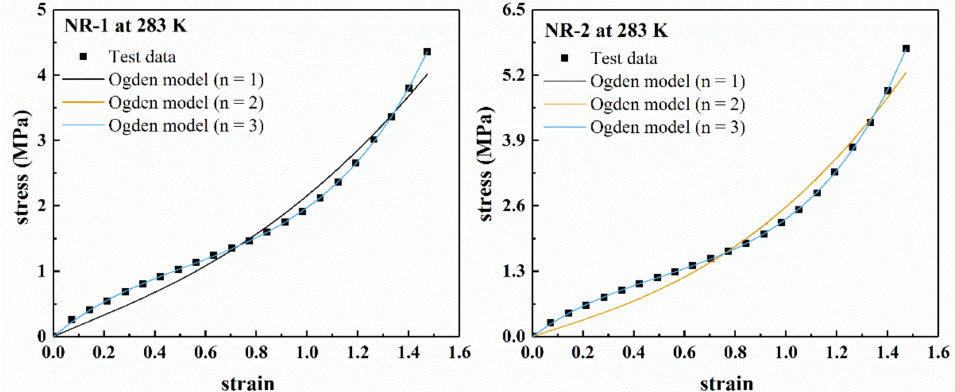
Figure 5. Fitting results of Ogden model for filled rubber NR-1 and NR-2 under uniaxial tension at 283